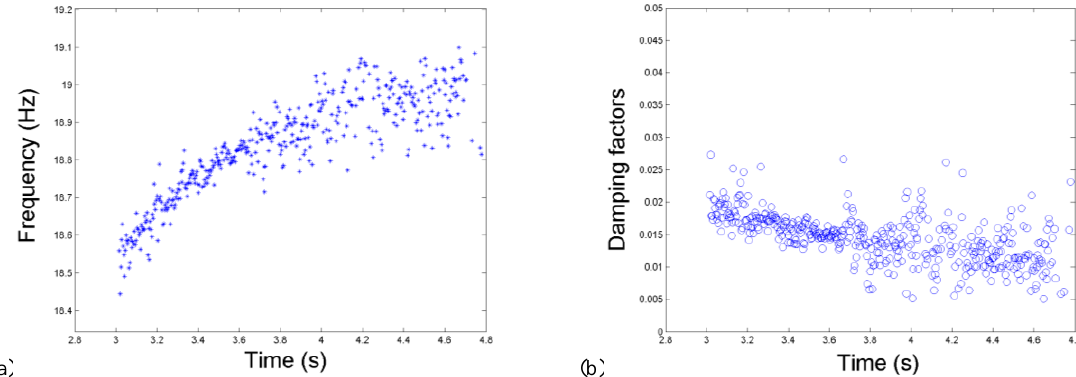
Fig. 6. Identified natural frequency (a) and damping factor (b), along the free decay of the release test.